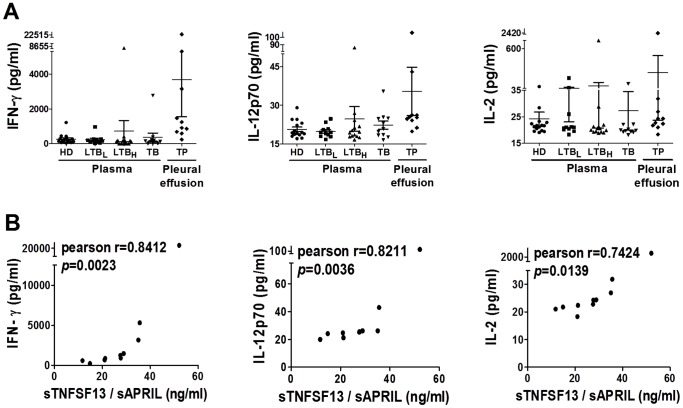
Analysis of the correlation between Th1 cytokines and sBAFF/sAPRIL. A. The levels of IFN-γ, IL-12p70 and IL-2 were detected in plasma (HD, n = 15; LTBL, n = 11; LTBH, n = 14; TB, n = 11) and pleural effusion (TP, n = 10) using Luminex technology. B. Significant positive correlations were identified between sAPRIL, and IFN-γ (Pearson’s correlation coefficient, r = 0.8412, p = 0.0023), IL-12p70 (Pearson’s correlation coefficient r = 0.8211, p = 0.0036) and IL-2 (Pearson’s correlation coefficient r = 0.7424, p = 0.0139) in the TP pleural effusion.